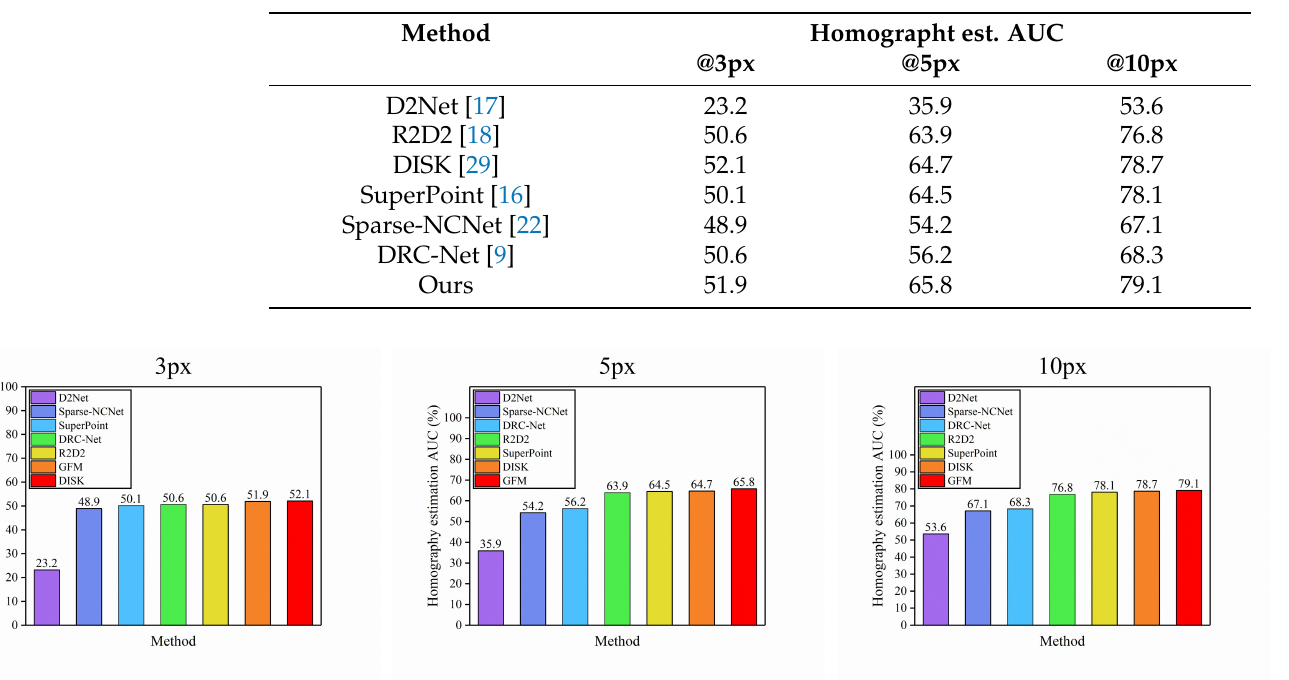
Table 2. Evaluation of State-of-the-art Approaches on HPatches.